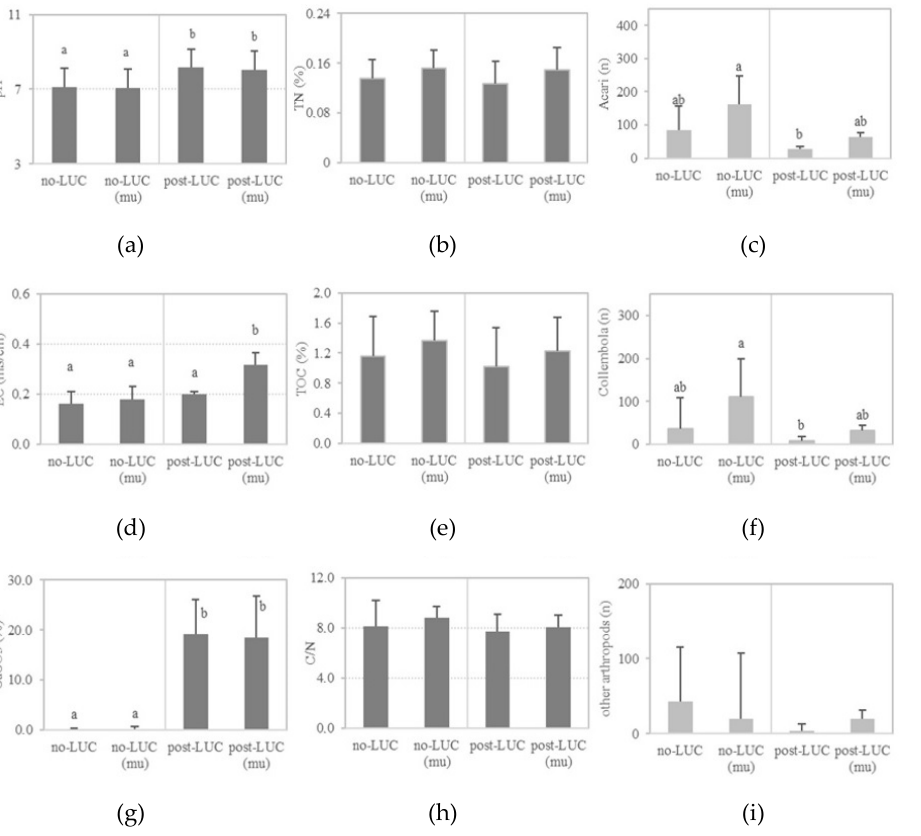
Figure 6. The evaluation of post-LUC mulching effects (mu) by separate ANOVAs on selected soil chemical properties (( a ) pH, ( b ) TN, ( d ) EC, ( e ) TOC, ( g ) CaCO 3 ( h ) C/N) (TOC = total organic carbon; TN = total nitrogen; EC = electrical conductivity; CaCO 3 = total equivalent Ca carbonate; C/N = Carbon-to-Nitrogen ratio) and the average of abundance of three main edaphic animal groups, ( c ) Acari, ( f ) Collembola, ( i ) other arthropods in four different management areas (no-LUC; no-LUC (mu); post-LUC; post-LUC (mu)). Error bars indicate the mean standard error and different letters show statistically significant differences between variables (ANOVA; Tukey’s test, p <